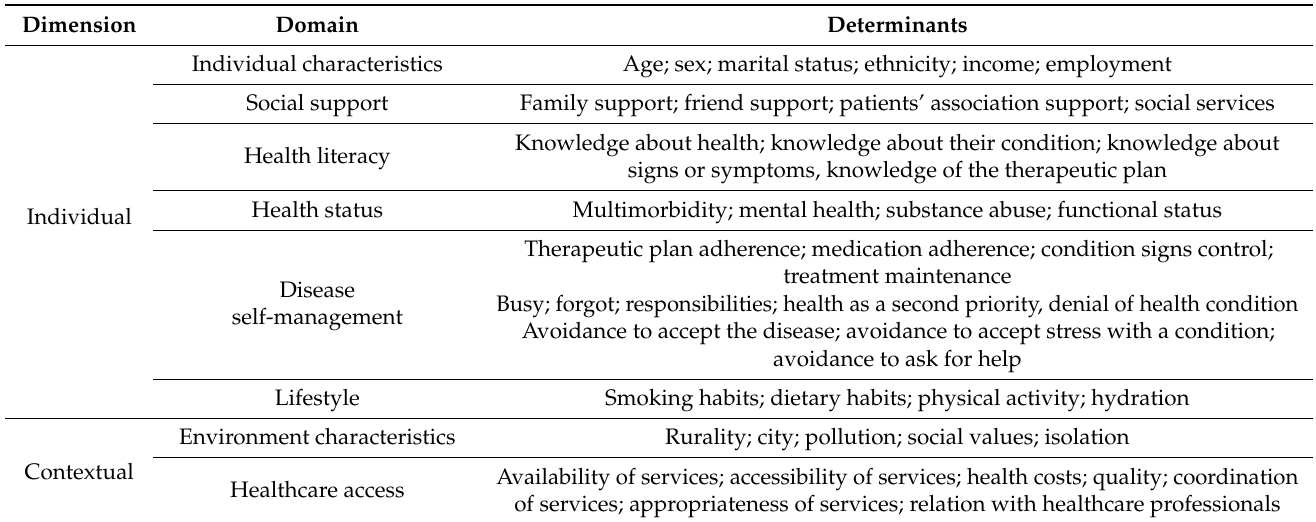
Table 1. Dimensions and domains of determinants of ACSC